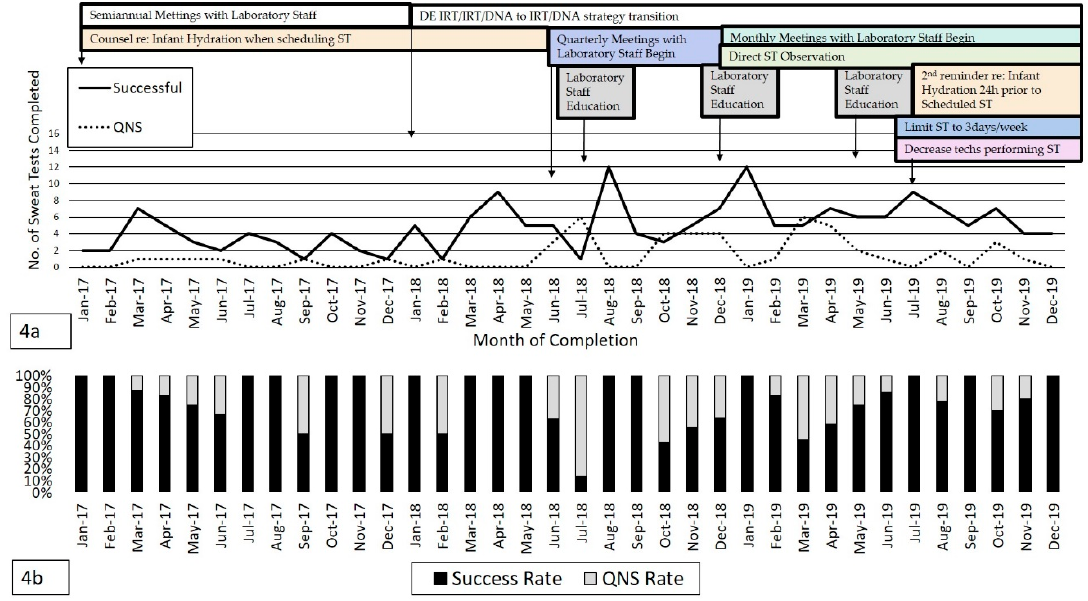
Figure 4. ( a ) Total monthly number of successful and ‘quantity not sufficient’ sweat chloride test results from January